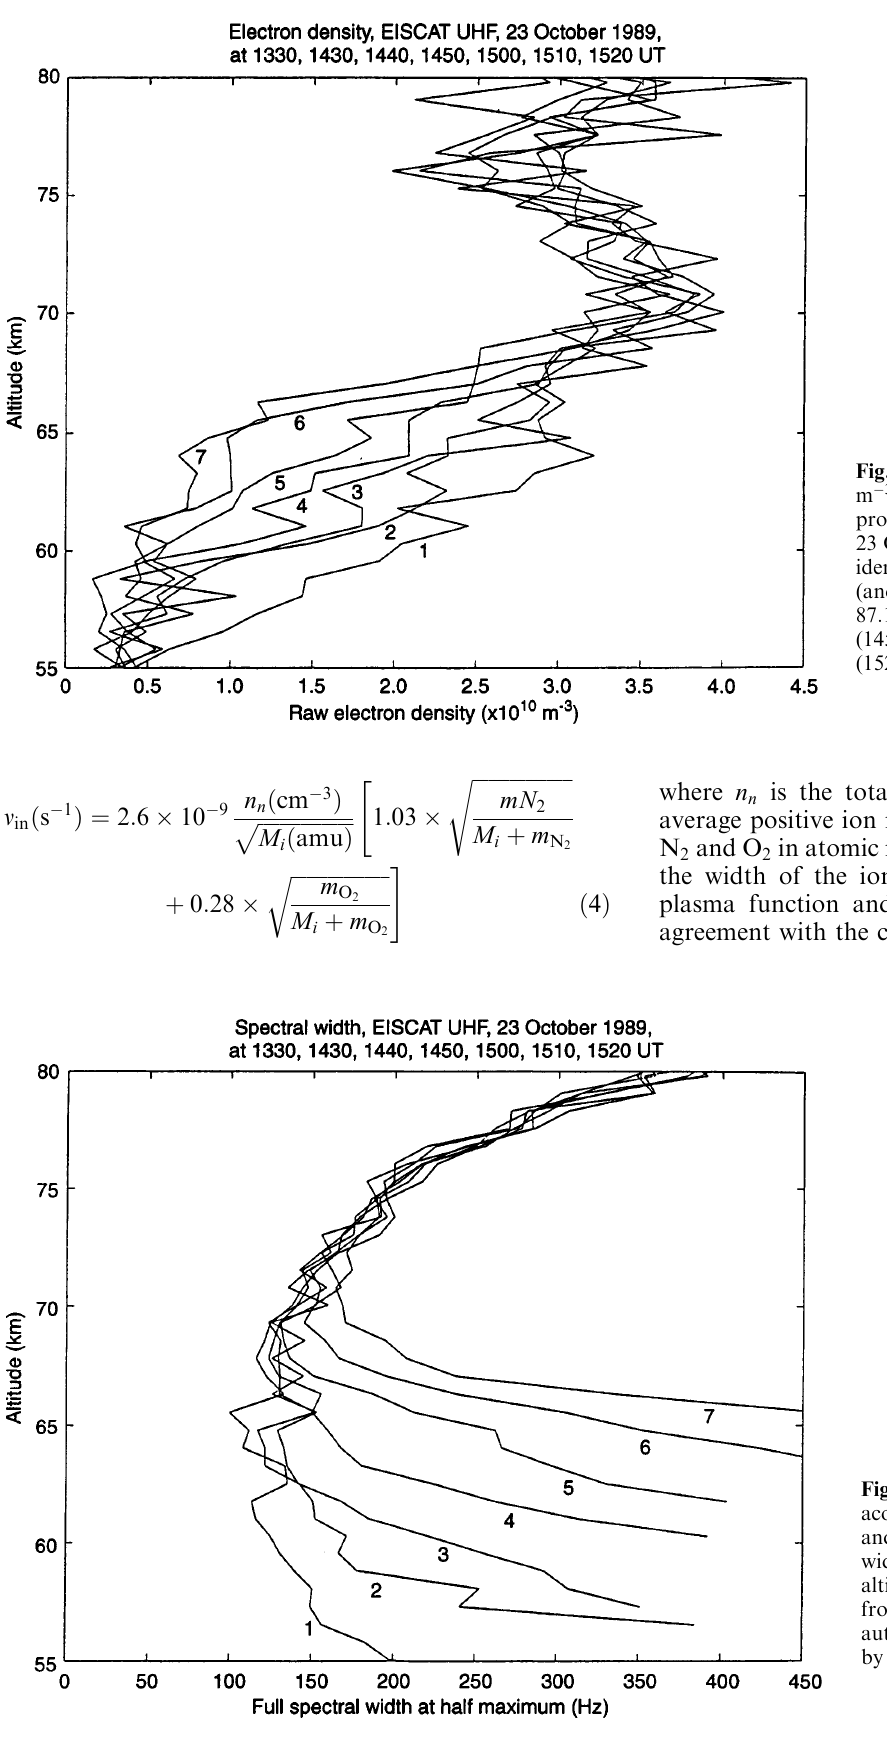
Fig. 3. Width of the spectra of the ion- acoustic fluctuations at the various heights and times of the event shown in Fig. 1. The widths are given in Hz in the 55–80 km altitude range. They were directly obtained from the correlation time of the plasma autocorrelation functions (ACF) measured by the UHF radar applying the